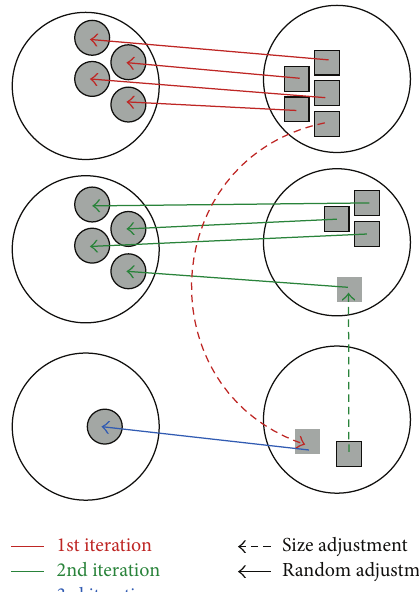
Figure 5: A diagram to demonstrate our deployment